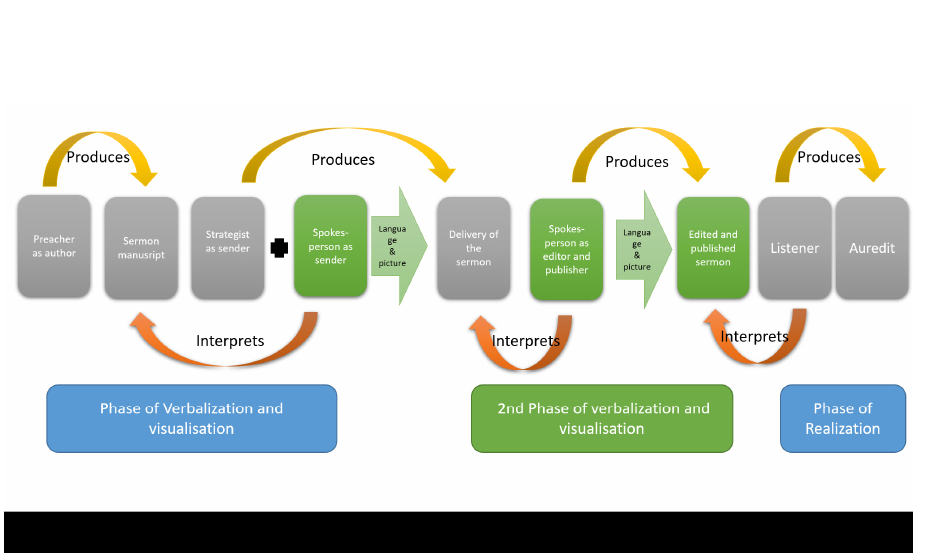
Figure 2. The Religious Digital Creatives (RDCs) involvement in the digitally mediated preach- ing